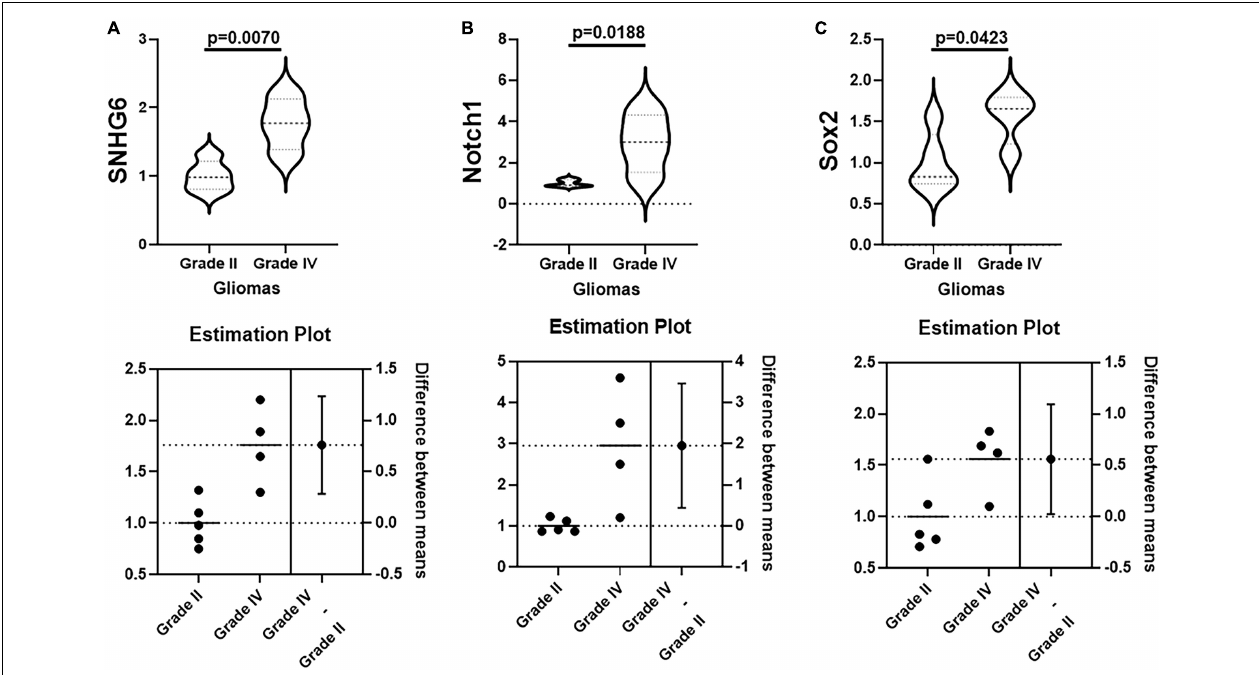
FIGURE 5 | SNHG6, Notch1, and Sox2 levels in glioma patients. Levels of (A) SNHG6, (B) Notch1, and (C) Sox2 were evaluated in patients with Grade II vs. Grade IV glioma, by qRT-PCR. The respective levels in Grade II patients were given a mean value of one and the relative expression levels in Grade IV patients representing fold-changes in the expression levels are plotted. Difference between means were calculated and the significance values are